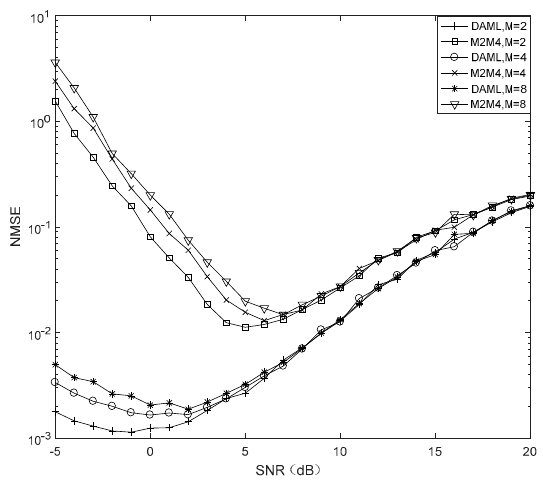
Figure 7. NMSE comparison of DA ML and M 2 M 4 in different M .